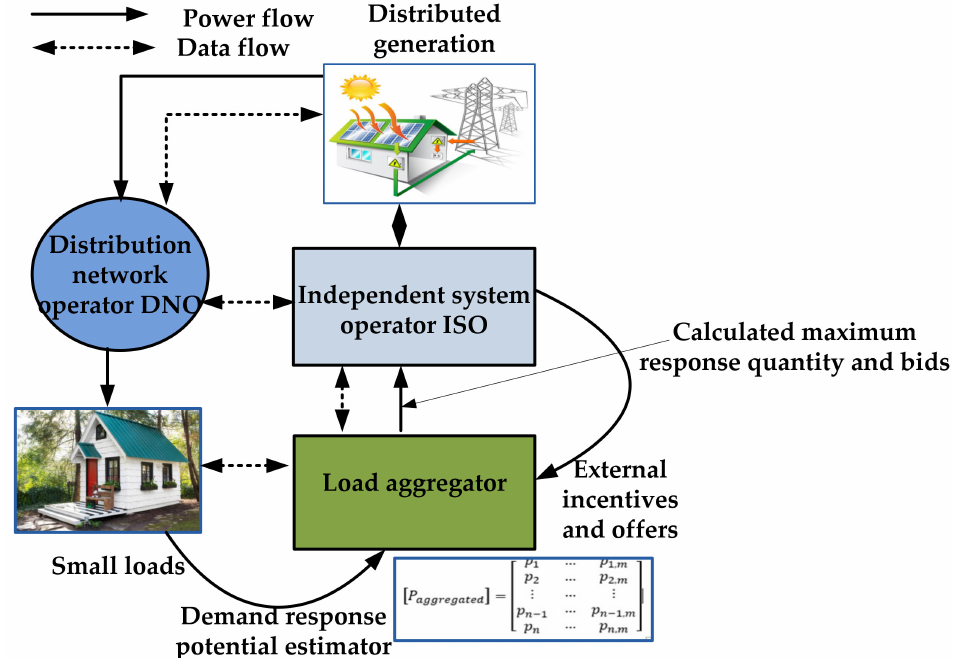
Figure 11. Function of DR